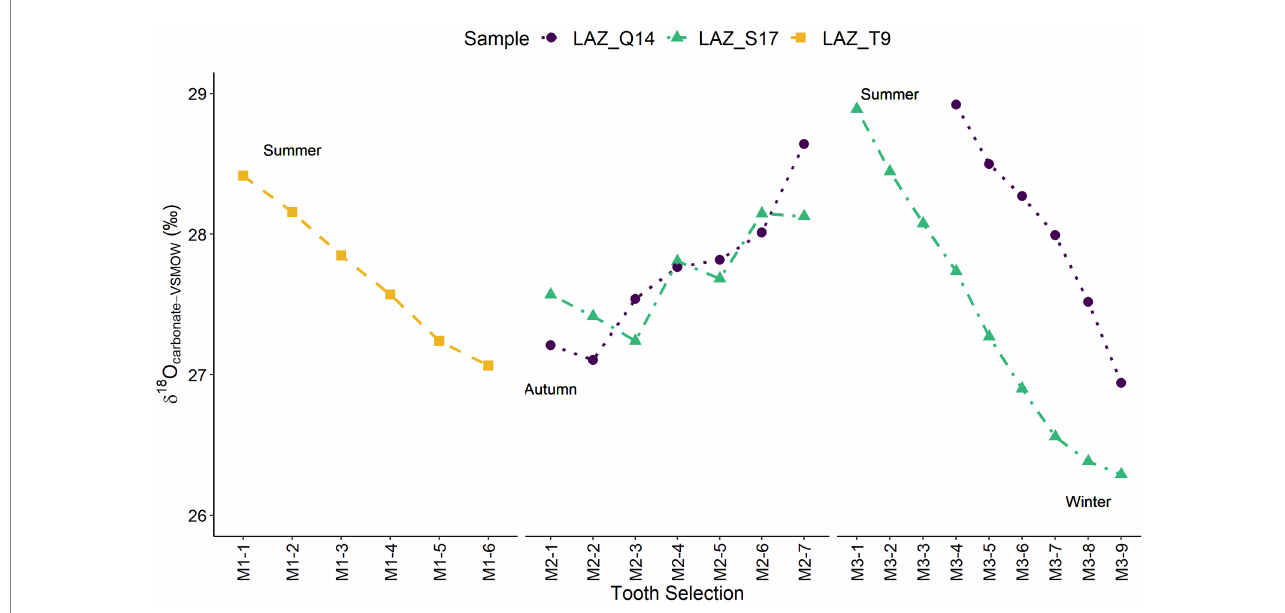
FIGURE 5 Plot of all δ 18 O data from enamel intra-tooth sections from first, second and third molars of three red deer from